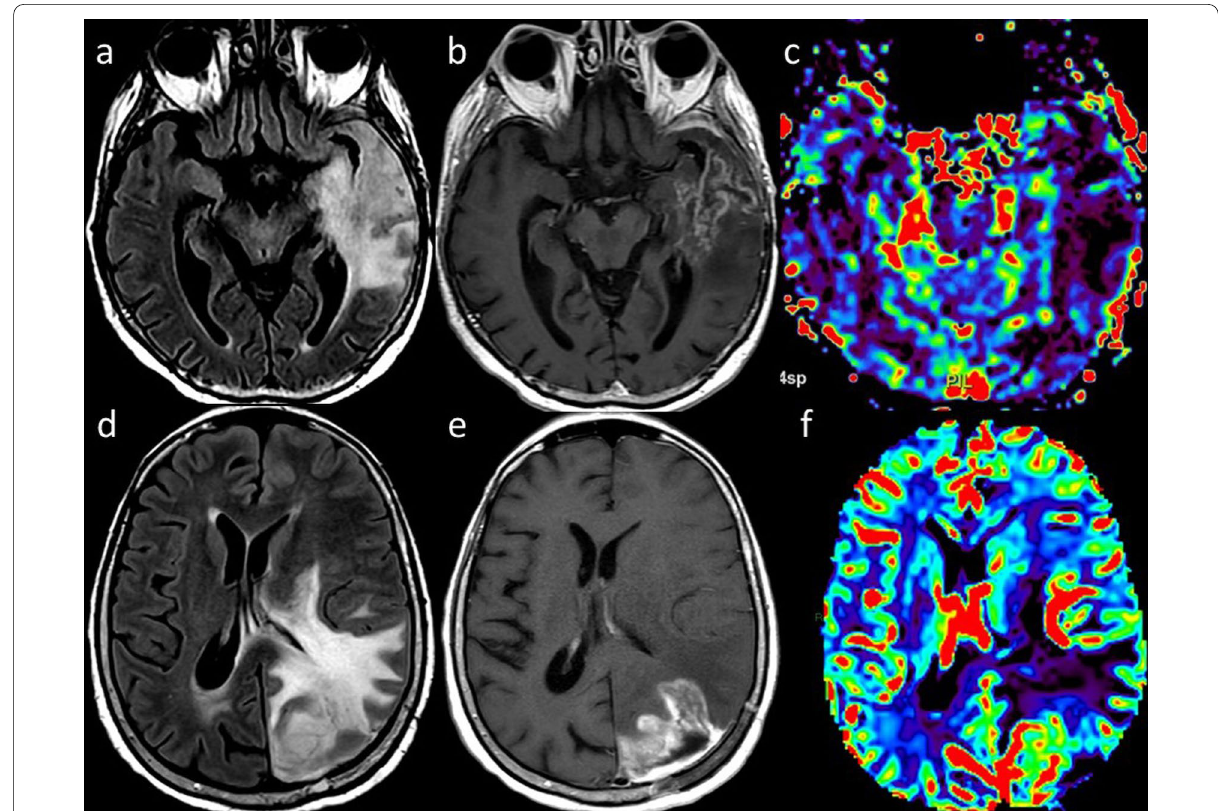
Fig. 4 Radionecrosis versus recurrent tumor. Axial FLAIR ( a ), contrast-enhanced T1-weighted ( b ) and DSC rCBV map ( c ) of a 72 year-old man with GBM treated with surgery and ChT/RT show brain swelling, high FLAIR signal, low”soap bubble” enhancement and reduced rCBV in the left temporal lobe, consistent with radionecrosis. Axial FLAIR ( d ), contrast-enhanced T1-weighted ( e ) and DSC rCBV map ( f ) of a 52-year-old woman with glioblastoma treated with surgery and ChT/RT show brain swelling, high FLAIR signal, intense enhancement and increased rCBV, indicative of tumor